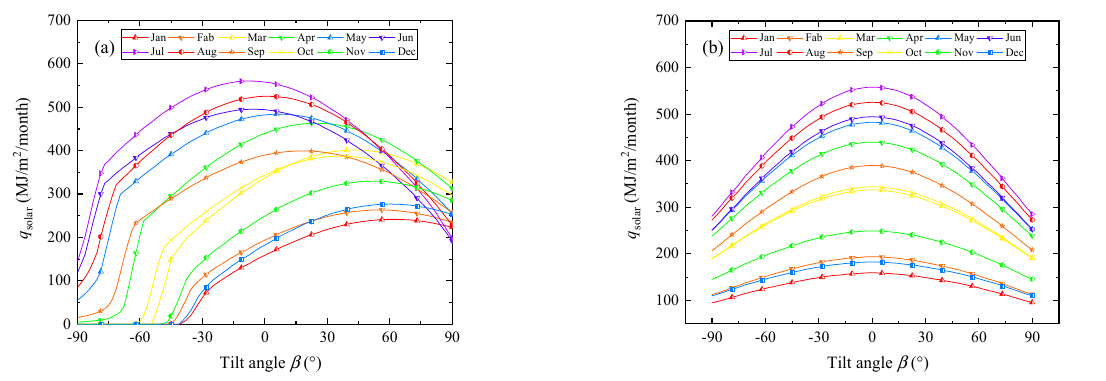
Figure 6. Monthly solar radiation intensity at various tilt angles in Nanjing city. ( a ) Tilting towards the south; ( b ) tilting towards the east.